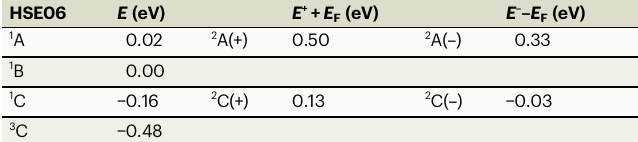
Table 1 | Relative energies, of the three carbon-pair con fi g- urations in the 512-atom supercell, for the neutral and the charged states, with respect to the neutral B -con fi